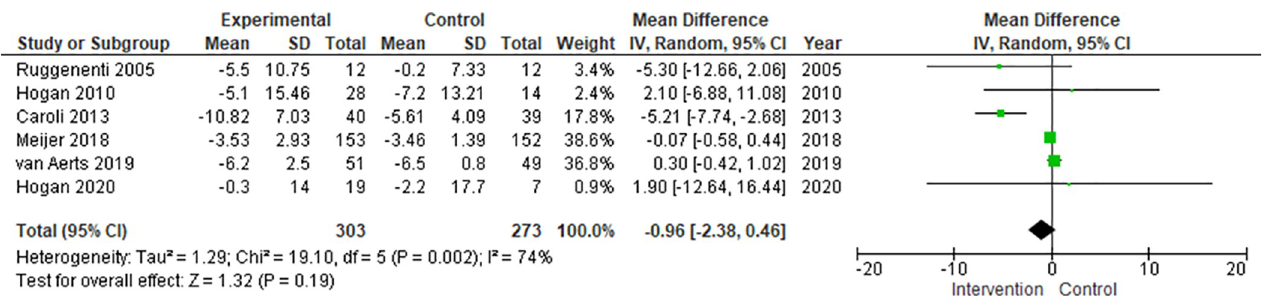
control group. We summarized serious adverse events associated with somatostatin analog in Table 3. All adverse events are presented in S8 Table.